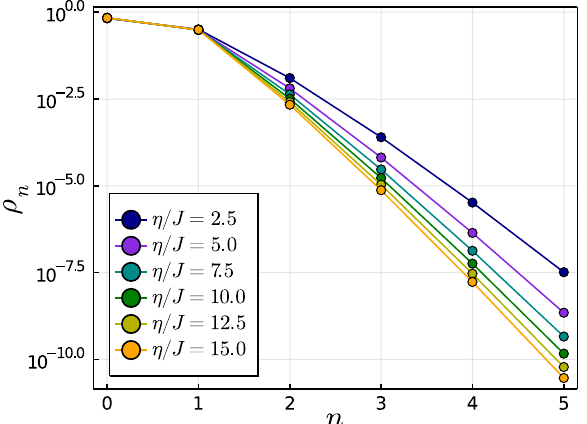
FIG. 16. Quantum-Zeno regime. Occupation probabilities of the DMFT NCA on-site reduced density matrix ρ a function of the number of particles per site and for different values of two-particle-loss rates η =J and for z ¼ 6 , J=U ¼ 0 . 133 and U ¼ 15 . For large η =J , we see that probabilities ρ suppressed exponentially (note the log scale), with a rate that increases with η =J , while the states with n ¼ 0 , 1 bosons, not affected by the losses, retain a population of the order of